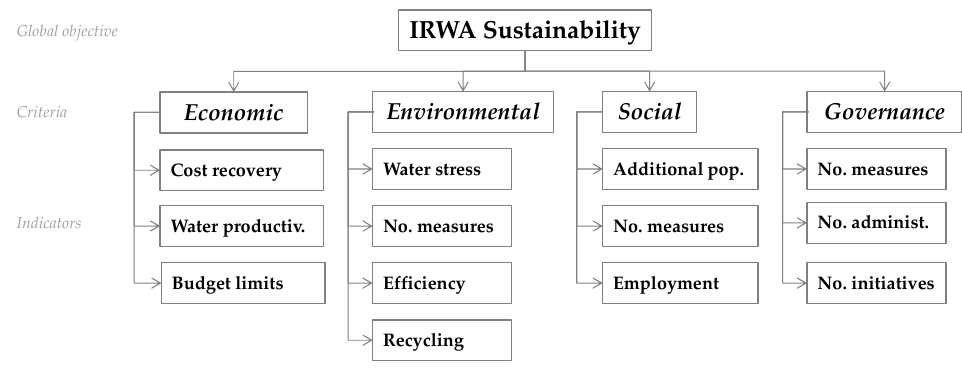
Figure 3. AHP structure.